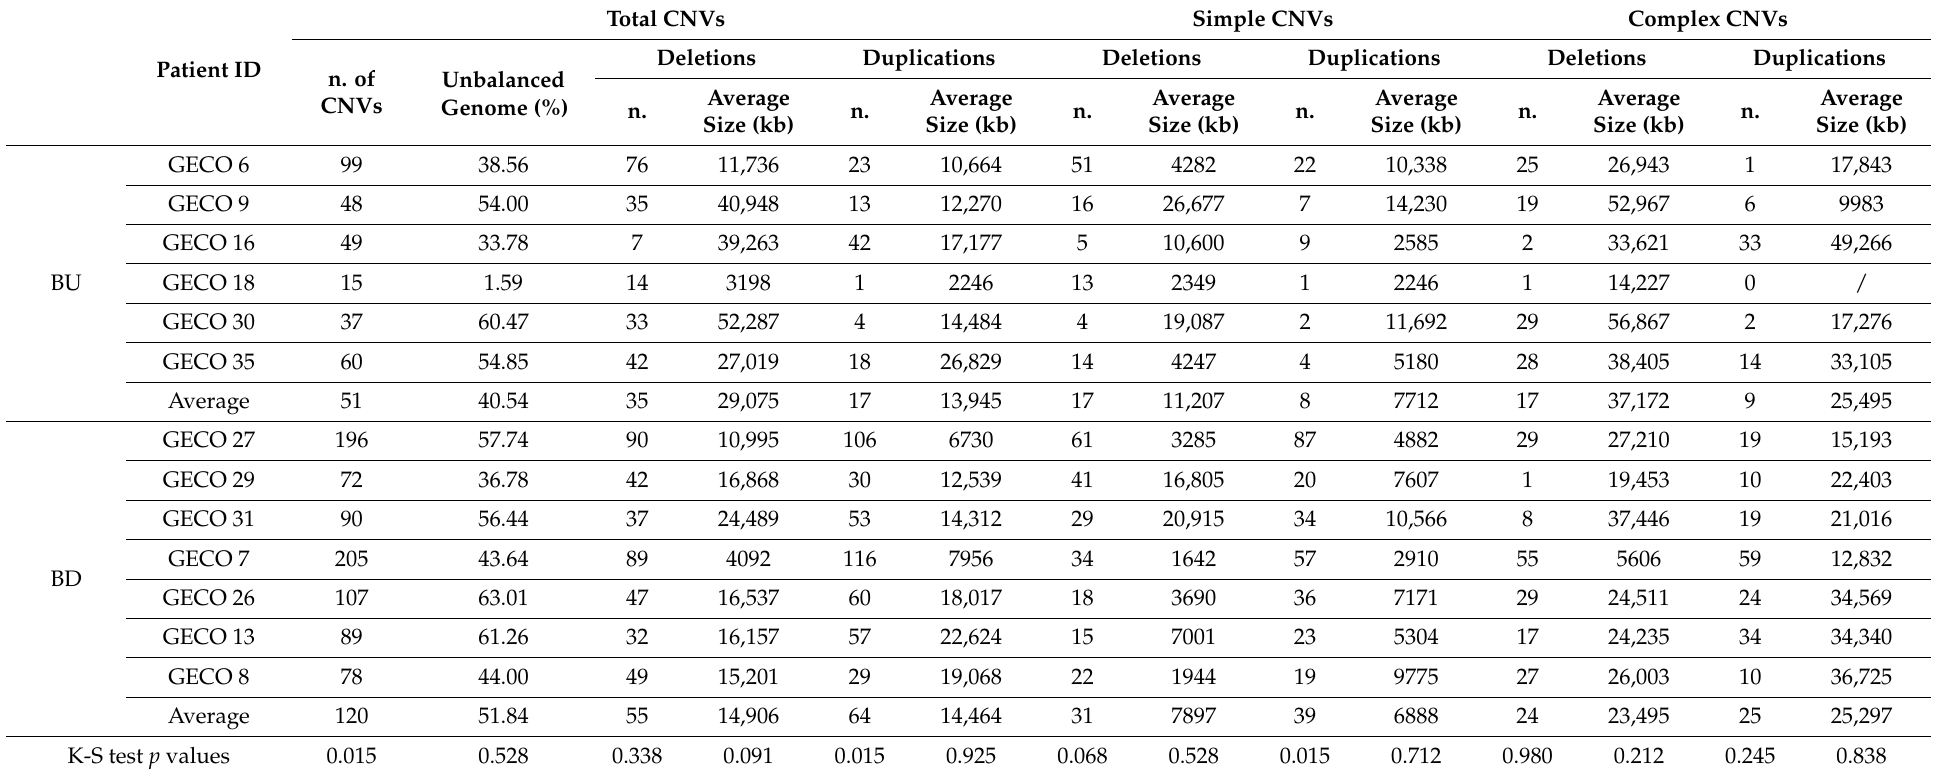
Table 2. Array-CGH+SNP analysis results. The table shows CNV features evaluated and compared between tumors of patients with defective and intact patients. Statistically significant values are in